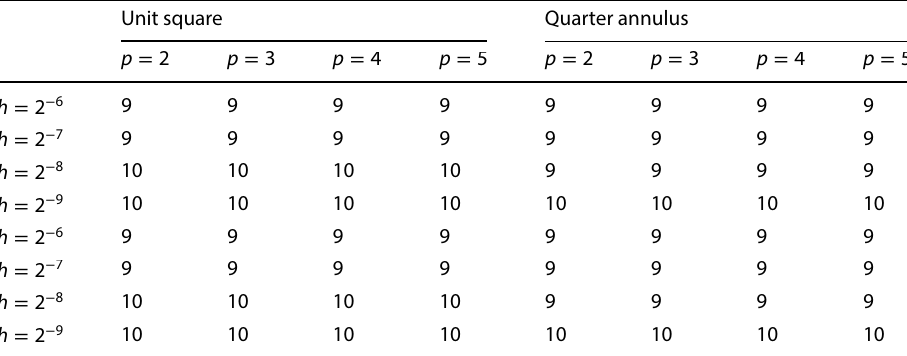
Here, p -multigrid (top) and the CG method (bottom) are adopted for the spatial solves and backward Euler for the time